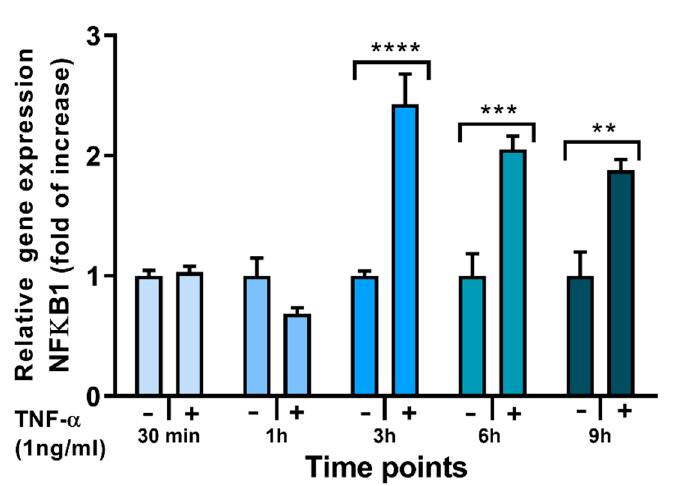
Figure 4. Expression of the NF κβ 1 gene in EA.hy926 cells stimulated (+) with TNF- α (1 ng/mL) for different times up to 9 h or not stimulated ( − ). Cq values were normalised by the geometric mean of reference targets RPL13A and CYC1 genes. Bars are mean ± SEM of 3 samples from 1 experiment. Stimulated and unstimulated cells were compared at each time point by Student’s t -test. ** p < 0.01, *** p < 0.001, **** p < 0.001 for stimulated vs. unstimulated cells.